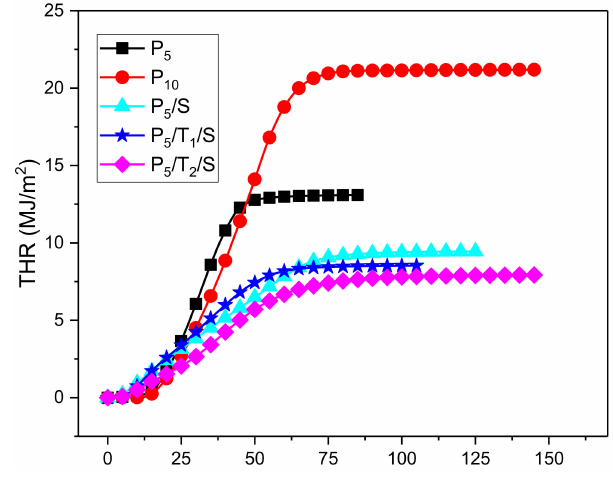
Figure 7. THR plots of PVA, PVA/NaOH, PVA/TA/NaOH